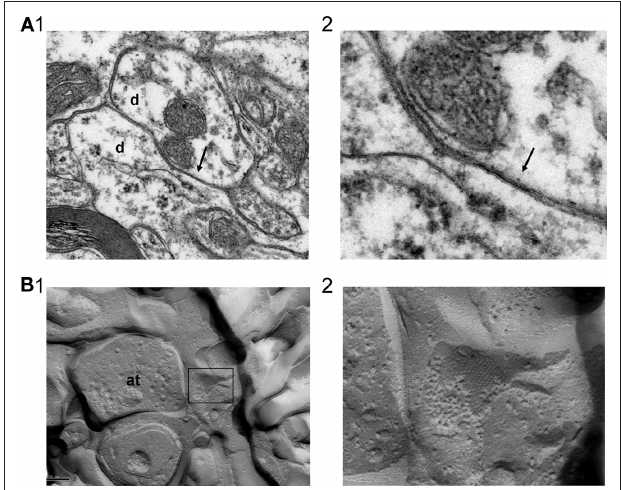
FiGurE 4 | ultrastructural evidence for GJs between neurons in the cat LGN. (A) GJ (arrow) formed between two dendritic elements (labeled “d”) in the cat LGN (A1) . The junction is shown at higher magnification in (A2) . (B) Example of a gap junctional plaque, contained within the box, in close association with a synapse-forming axon terminal (labeled “at”) (B1) . The plaque is shown at higher magnification in (B2) .